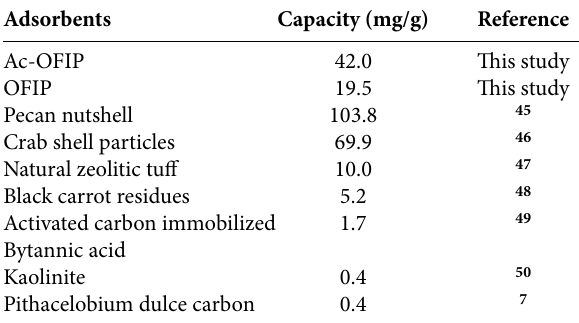
Table 5. Comparison of maximum Mn (II) adsorption capacities with other adsorbents.